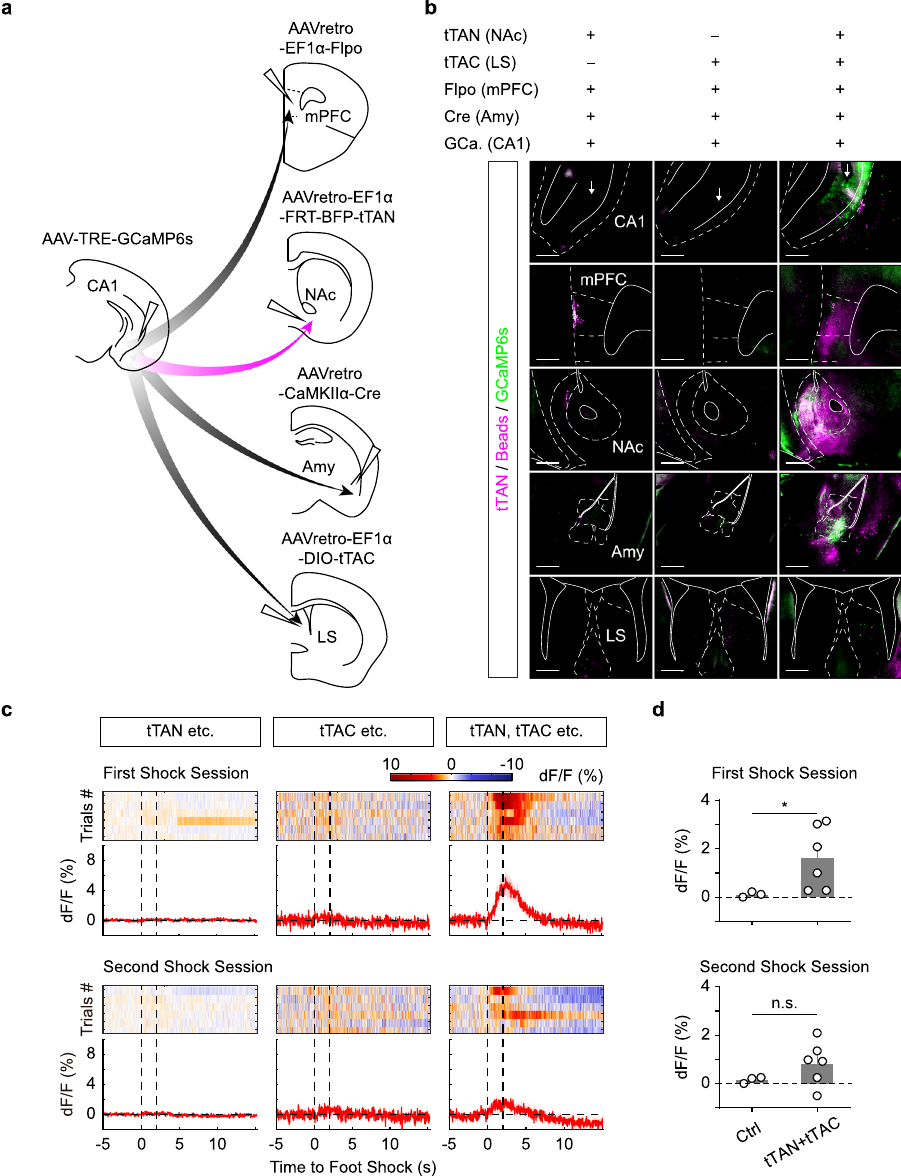
Fig. 6 Quintuple features-based Ca 2 + recording. a Scheme illustrating AAV injections to de fi ne cells by fi ve features including quadruple retrograde tracings and pyramidal-cell-speci fi c (CaMKII α promoter) Ca 2 + recording. b Examples showing fl uorescence of GCaMP6s (green), tTAN (magenta) and blue beads (magenta). mPFC: medial prefrontal cortex. NAc: nucleus accumbens. Amy: amygdala. LS: lateral septum. Scale bars: 500 µ m. c Examples of heatmaps and averaged traces of Ca 2 + signals upon foot shocks between dash vertical lines. d Summary of foot shocks evoked Ca 2 + responses in tTAN + tTAC ( N = 6 animals) and control (1 animal for tTAN and 2 animals for tTAC) groups. First session, 1.6 ± 0.5% vs. 0.1 ± 0.06%; Mann-Whitney U test, * P = 0.0238; Second session, 0.8 ± 0.4% vs. 0.2 ± 0.1%, Mann-Whitney U test, P = 0.26. Data summary: mean ± SEM. Statistical analysis: two sided. Source data are provided as a Source Data fi